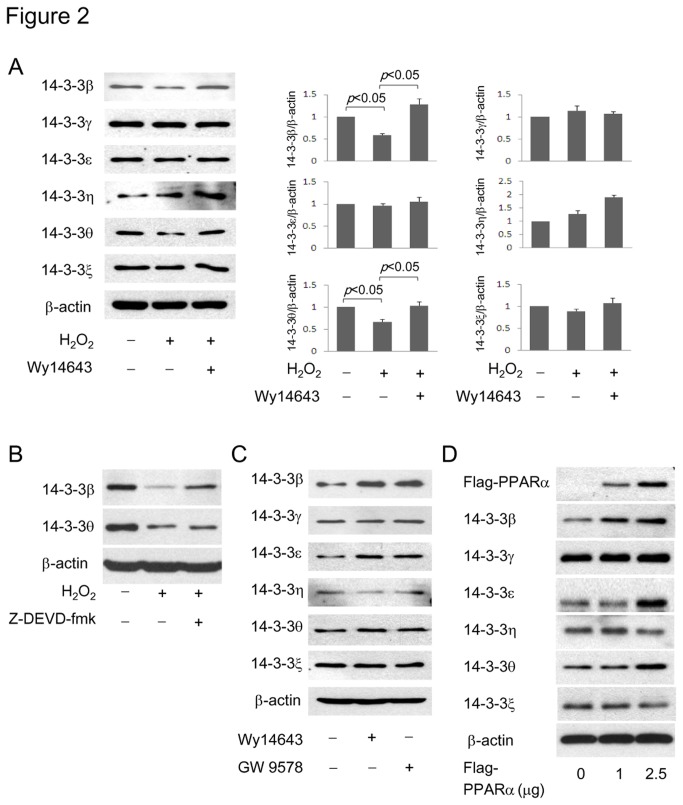
PPARα rescues H2O2-induced depression of 14-3-3β and θ levels.(A) A-10 cells were pretreated with Wy14,643 (50 µM) followed by H2O2 (0.8 mM). 14-3-3 proteins were analyzed by Western blotting. Left panel shows representative Western blots and right panel shows densitometry analysis. (B) Cells were pretreated with caspase 3 inhibitor, Z-DEVD-fmk (20 µM) followed by H2O2. 14-3-3β and θ were analyzed by Western blotting. (C) Cells were treated with Wy14,643 (50 µM) or GW9578 (5 µM) and changes in 14-3-3 proteins were analyzed. (D) Cells were transfected with PPARα vectors and 14-3-3 proteins were analyzed. Each error bar denotes mean±SEM and all blots are representative of n≥3.